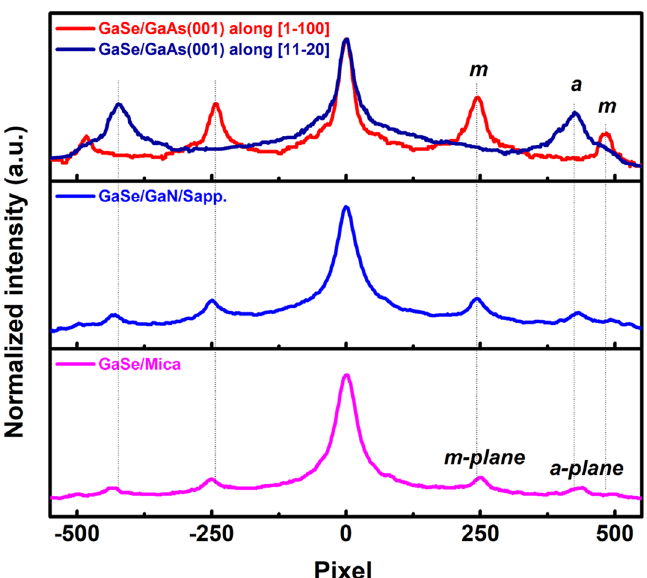
Figure 3. RHEED intensity profiles of the GaSe layers on various